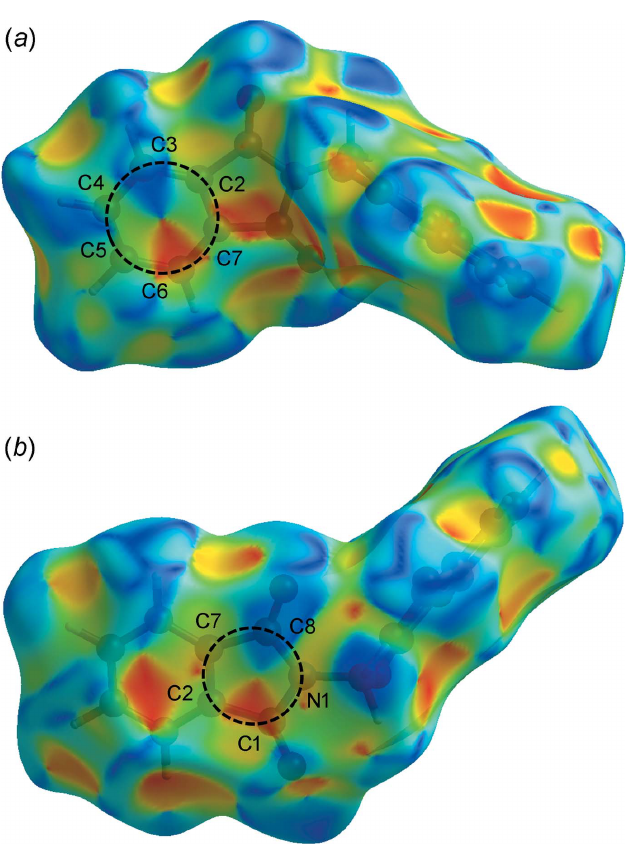
Figure 6 The Hirshfeld surface mapped over shape-index for 1 (cid:3) .